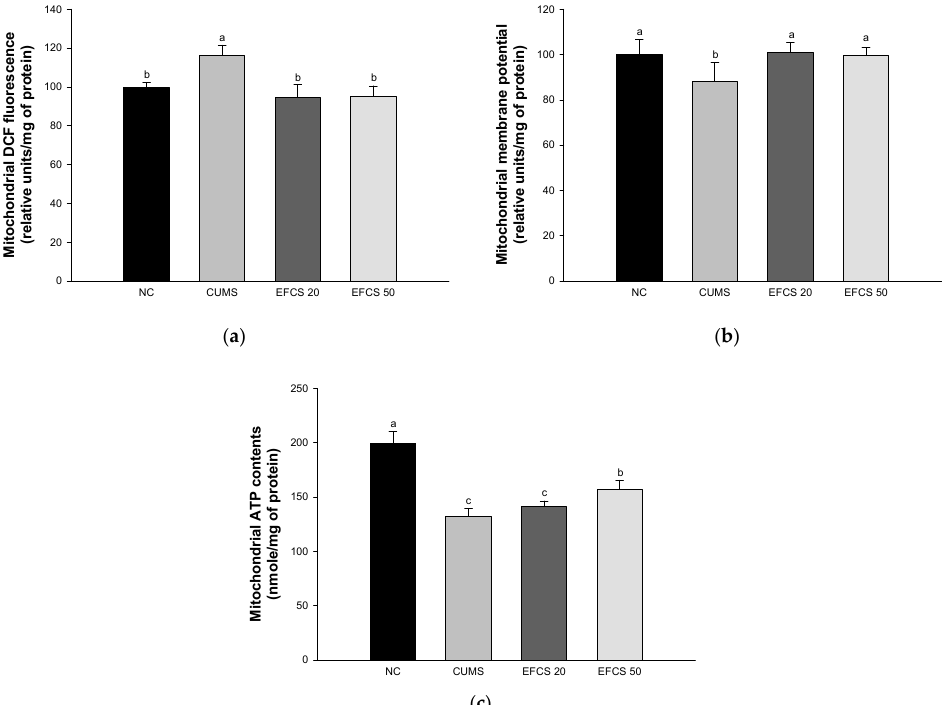
Figure 5. Effect of ethyl acetate fraction from Cedrela sinensis (EFCS) on CUMS-induced mitochondrial dysfunction. ROS production contents ( a ), mitochondrial membrane potential (MMP) contents ( b ), and mitochondrial ATP contents ( c ). Results shown are mean ± SD ( n = 5). Data are statistically represented at p < 0.05, and different lowercase letters indicate statistical significance. Means with the same letter are not significantly different.